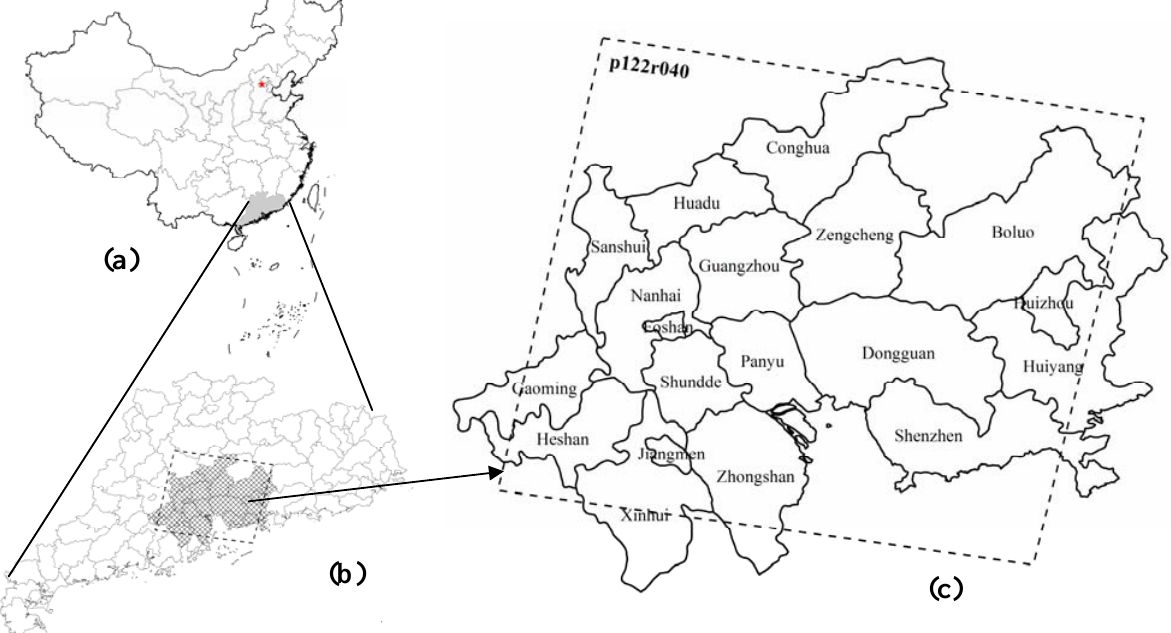
Figure 1. Location of Pearl River Delta. (a) Bound of China, (b) Administrative divisions of Guangdong Province and study area, and (c) Study